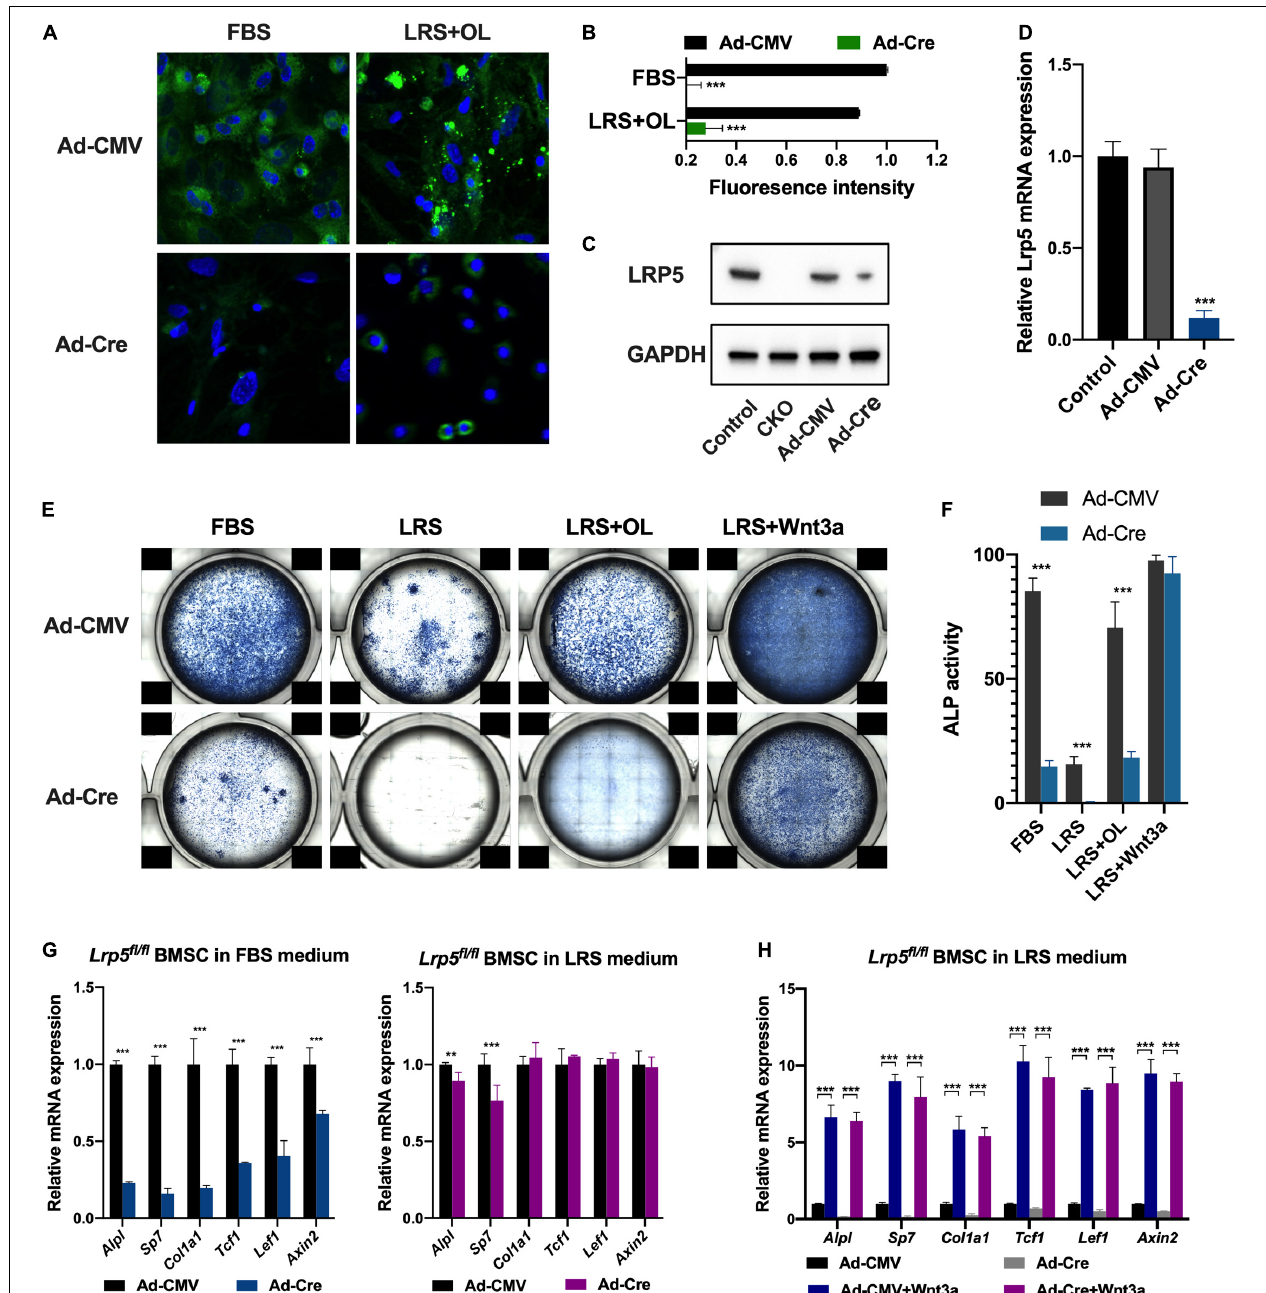
FIGURE 4 | Low-density lipoprotein receptor-related protein 5 (Lrp5 ) ablation in bone marrow mesenchymal stromal cells (BMSCs) impairs lipid uptake and osteogenesis. (A) BODIPY TM staining revealed significantly decreased lipid droplets in BMSC cytoplasm after Lrp5 ablation using adenoviral Cre-recombinase. (B) Quantified fluorescence intensity of lipid droplets in BMSC cytoplasm indicating impaired lipid uptake of Lrp5 -KO BMSCs. (C) LRP5 protein expression in BMSCs harvested from postnatal day 0 (P0) control mice, conditional knockout (CKO) mice, Lrp5 -control BMSC, and Lrp5 -KO BMSCs. (D) qRT-PCR validated the knockout effect of adenoviral-Cre infection on Lrp5 fl / fl BMSCs. (E) Alkaline phosphatase (ALP) staining of control and Lrp5 -KO BMSCs 7 days after osteogenic induction in culture medium with normal fetal bovine serum (FBS), lipid-reduced serum (LRS), LRS with 100 µ M oleate treatment, and LRS with recombinant 100 ng/ml Wnt3a treatment, respectively. (F) ALP activity of BMSCs 7 days after osteogenic induction in different culture mediums. (G) mRNA expression levels in control and Lrp5 -KO BMSCs of osteogenic genes Alpl , Sp7 , and Col1a1 and Wnt target genes Tcf1 , Lef1 , and Axin2 after 7 days of osteogenic induction in FBS or LRS culture medium. (H) mRNA expression levels in control and Lrp5 -KO BMSCs of osteogenic genes Alpl , Sp7 , and Col1a1 as well as Wnt target genes Tcf1 , Lef1 , and Axin2 after 7 days of induction in LRS culture medium with or without Wnt3a treatment, * p < 0.05, ** p < 0.01, and *** p < 0.001.